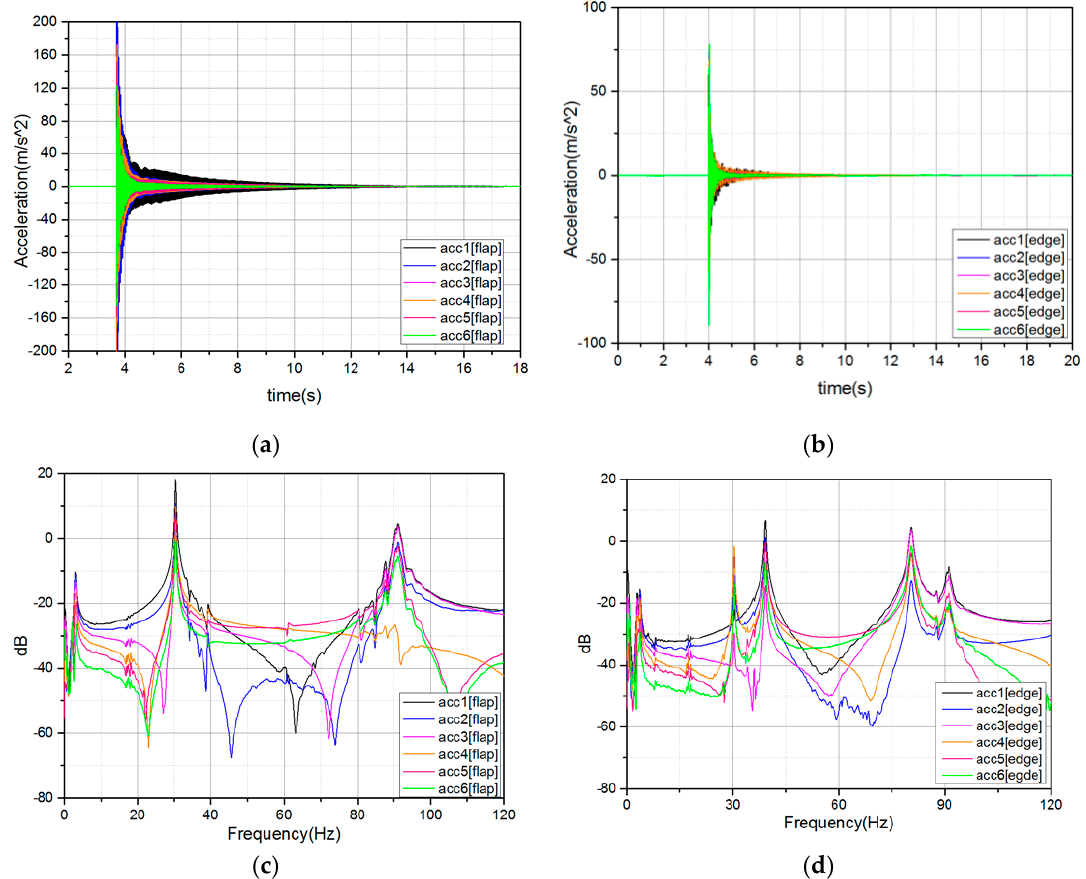
Figure 18. Modal testing results: ( a ) time signal(flapwise), ( b ) time signal(edgewise), ( c ) frequency response(flapwise), and ( d ) frequency response(edgewise).